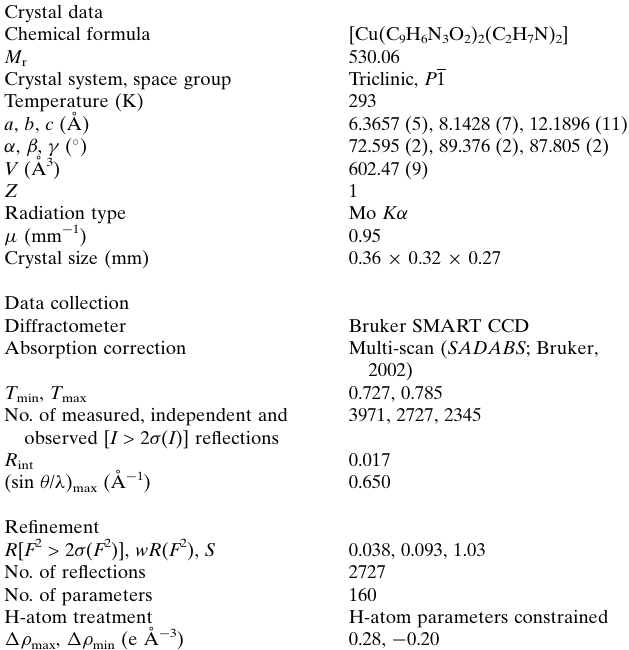
Figure 1 The molecular structure of the title compound, with atom labelling and displacement ellipsoids drawn at the 30% probability level. H atoms have been omitted for clarity. [Symmetry code: (A) (cid:4) x + 2, (cid:4) y , (cid:4) z +